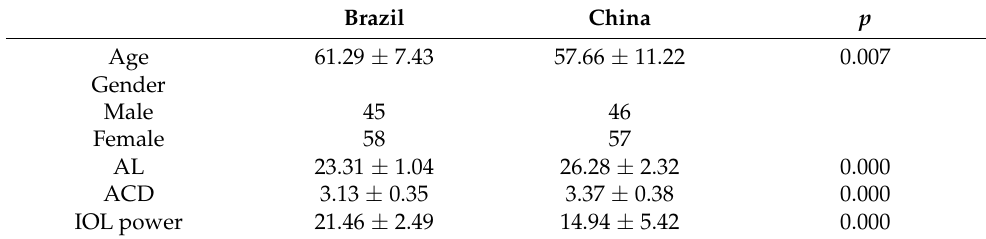
Table 1. Demographic information.